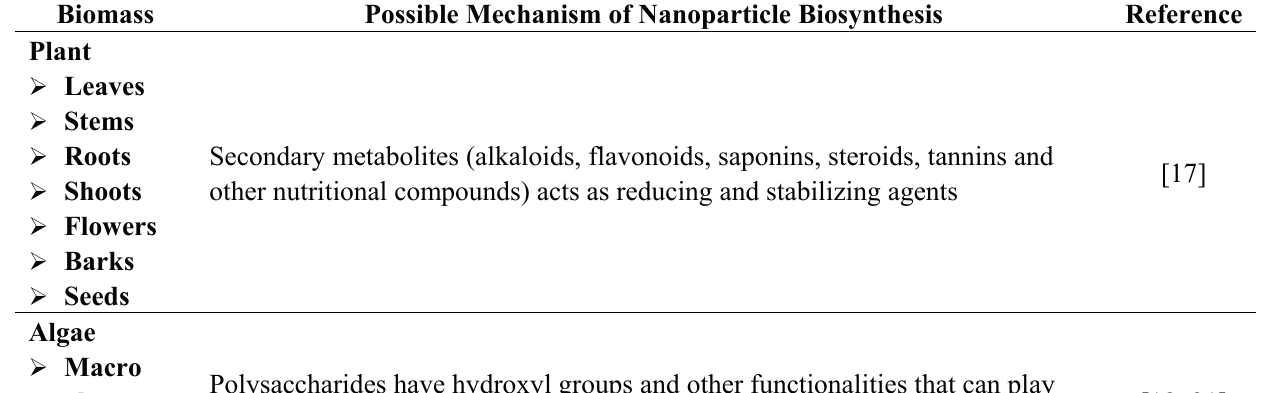
Table 1. Possible mechanism of nanoparticle biosynthesis using different sources. Biomass Possible Mechanism of Nanoparticle